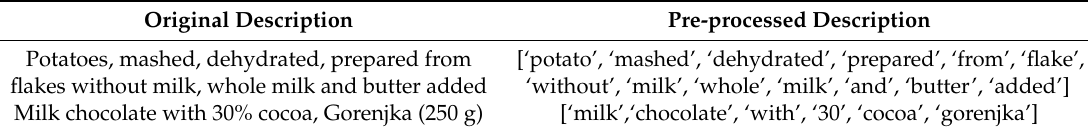
Table 3. Examples of pre-processed English